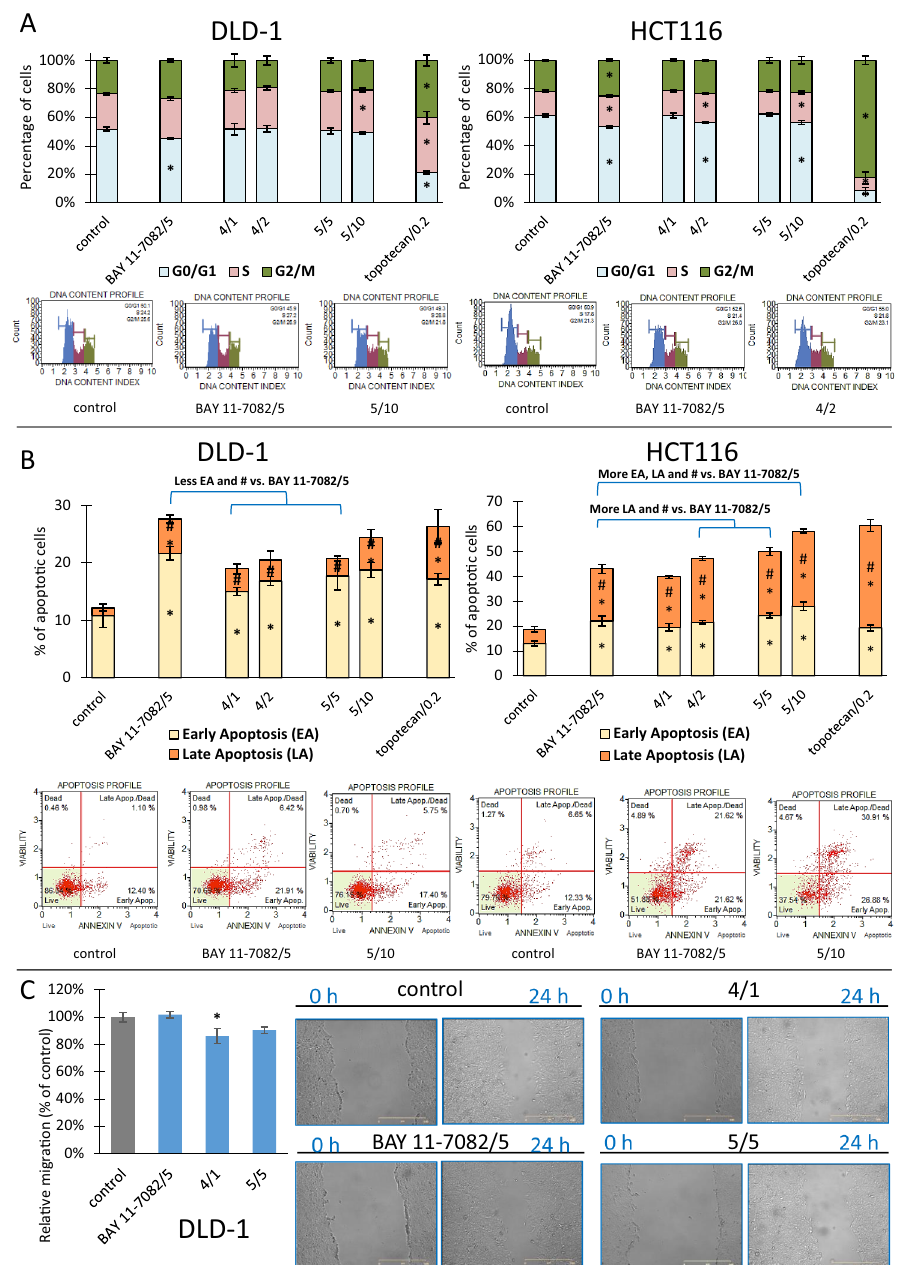
Figure 9. The impact of BAY 11-7082 (5 µM), chalcone 4 and chalcone 5 : ( A ) on cell cycle distribution in DLD-1 cells and HCT116 cells, ( B ) on induction of apoptosis in DLD-1 cells and HCT116 cells, ( C ) on migration of DLD-1 cells. ( A ) The percentage of cells in G1/G0, S and G2/M phases was analyzed by the flow cytometry after staining with propidium iodide (PI). Topotecan (0.2 µM) was used as a reference for cell cycle arrest. Exemplary plots are presented under the diagrams. Results (mean ± SEM) were calculated from three separate experiments. Asterisk: mean values were significantly different from the control group (p ≤ 0.05). ( B ) The percentage of cells in the early and late stage of the apoptosis was evaluated by the flow cytometry measurements after staining with Annexin V and 7-Aminoactinomycin D (7-AAD). Topotecan (0.2 µM) was used as a reference for induction of apoptosis. Exemplary plots are presented under the diagrams. Results (mean ± SEM) were calculated from three separate experiments. Asterisk: mean values were significantly different from the control group (or BAY 11-7082 treatment) and early apoptosis (EA) or late apoptosis (LA); Asterisk: mean values were significantly different from the control group (or BAY 11-7082 treatment) and Total apoptosis (p ≤ 0.05). (C) Wound healing assay was performed. Exemplary microscopic images of the scratch, which were taken at the beginning and after 24 h of incubation with the compounds, are shown. Results (mean ± SEM) were calculated from three separate experiments. Scale bar represents 500 μm. Asterisk: mean values were significantly different from the control group (p ≤